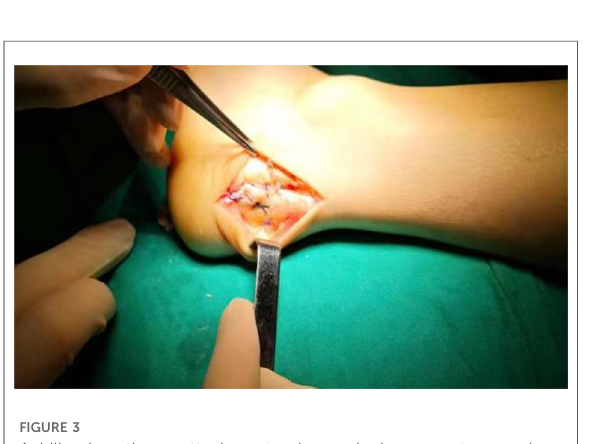
FIGURE 4 Patients were suggested to wear a postoperative walking